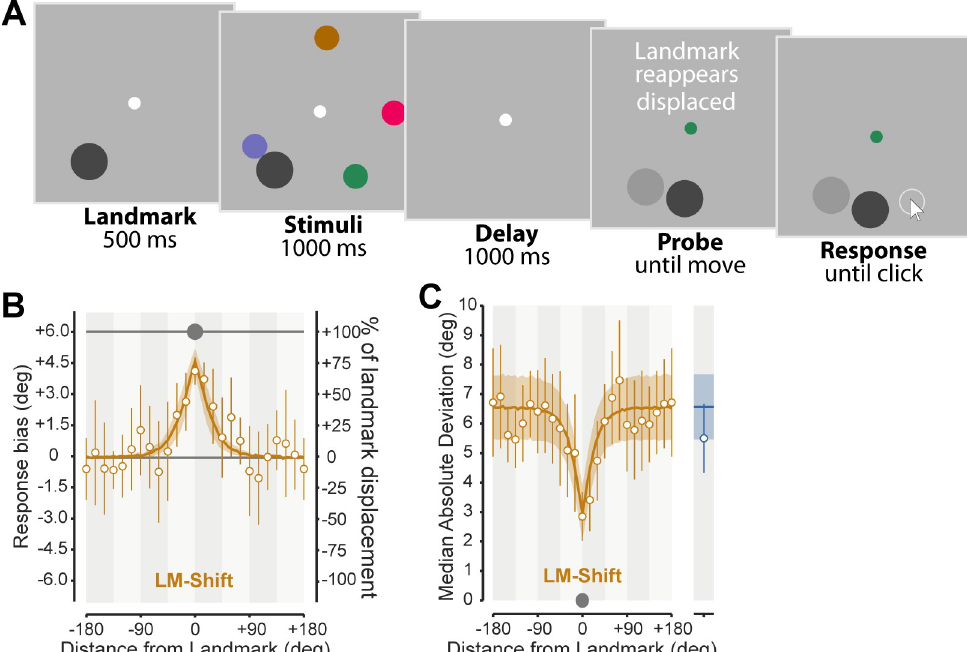
Fig 4. Experiment three. (A) Example LM-SHIFT trial. When the landmark returned, it was shifted by either 6˚ clockwise or counter-clockwise (exaggerated above for clarity; light gray disk illustrates previous landmark location and was not visible in the experiment). If participants used the post-shift location to anchor their allocentric estimates, we would expect their responses to be biased in the direction of the displacement, with the magnitude related to the reliability of the allocentric cue. (B) The response bias measured in the direction of the shift (magnitude 6˚ indicated by gray line), as a function of distance from the landmark. The data reveals a consistent bias in the direction of the displacement, which may be either towards or away from the visible landmark location. Bias magnitude depended on distance from the landmark with a peak of ~80% of the shift. (C) Spatially specific decreases in response variability near the landmark in LM-SHIFT. Note that for clarity the bias was subtracted prior to calculation of the median absolute deviation. The model predictions (overlaid) simultaneously capture landmark effects on both bias (B) and variability (C), without any additional free